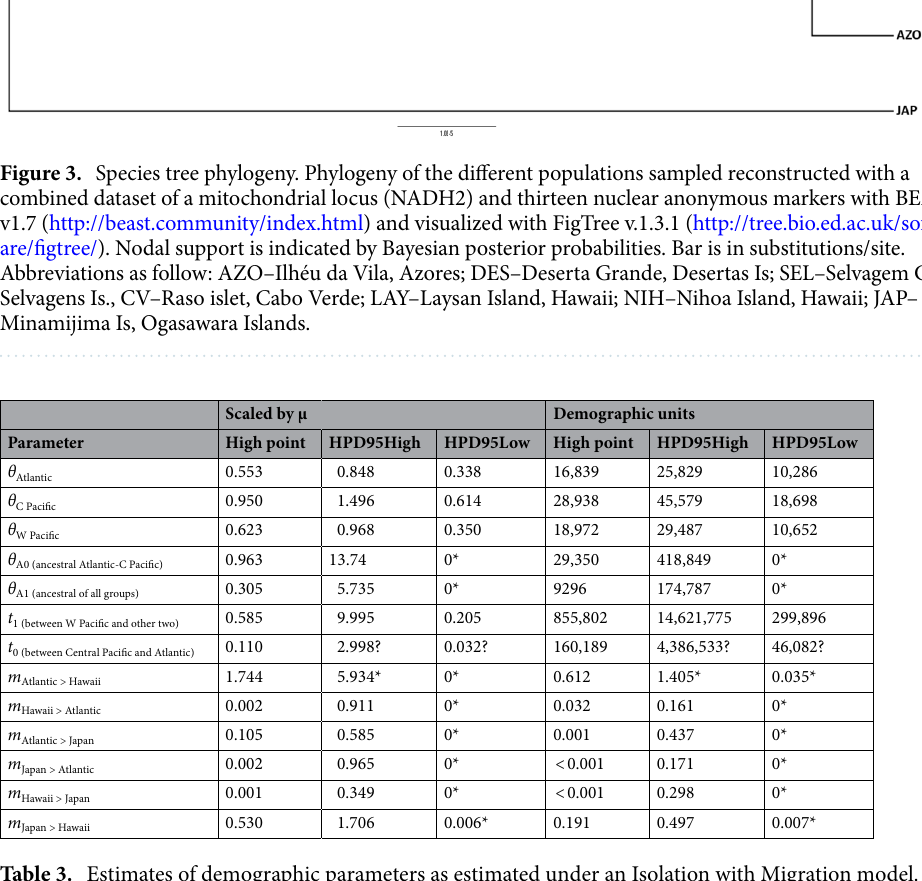
Table 3. Estimates of demographic parameters as estimated under an Isolation with Migration model. For the calculation of demographic units, we considered a generation time of 12 years, and a substitution rate per locus ( NADH 2 ) of 2.8 × 10 –8 . For the migration parameters, the first population shown is the recipient, and the second population the donor. The 95% highest posterior densities (HPD95) are shown for each parameter. ? HPD interval may be incorrect due to multiple peaks. * Posterior density failed to converge near the limit of the